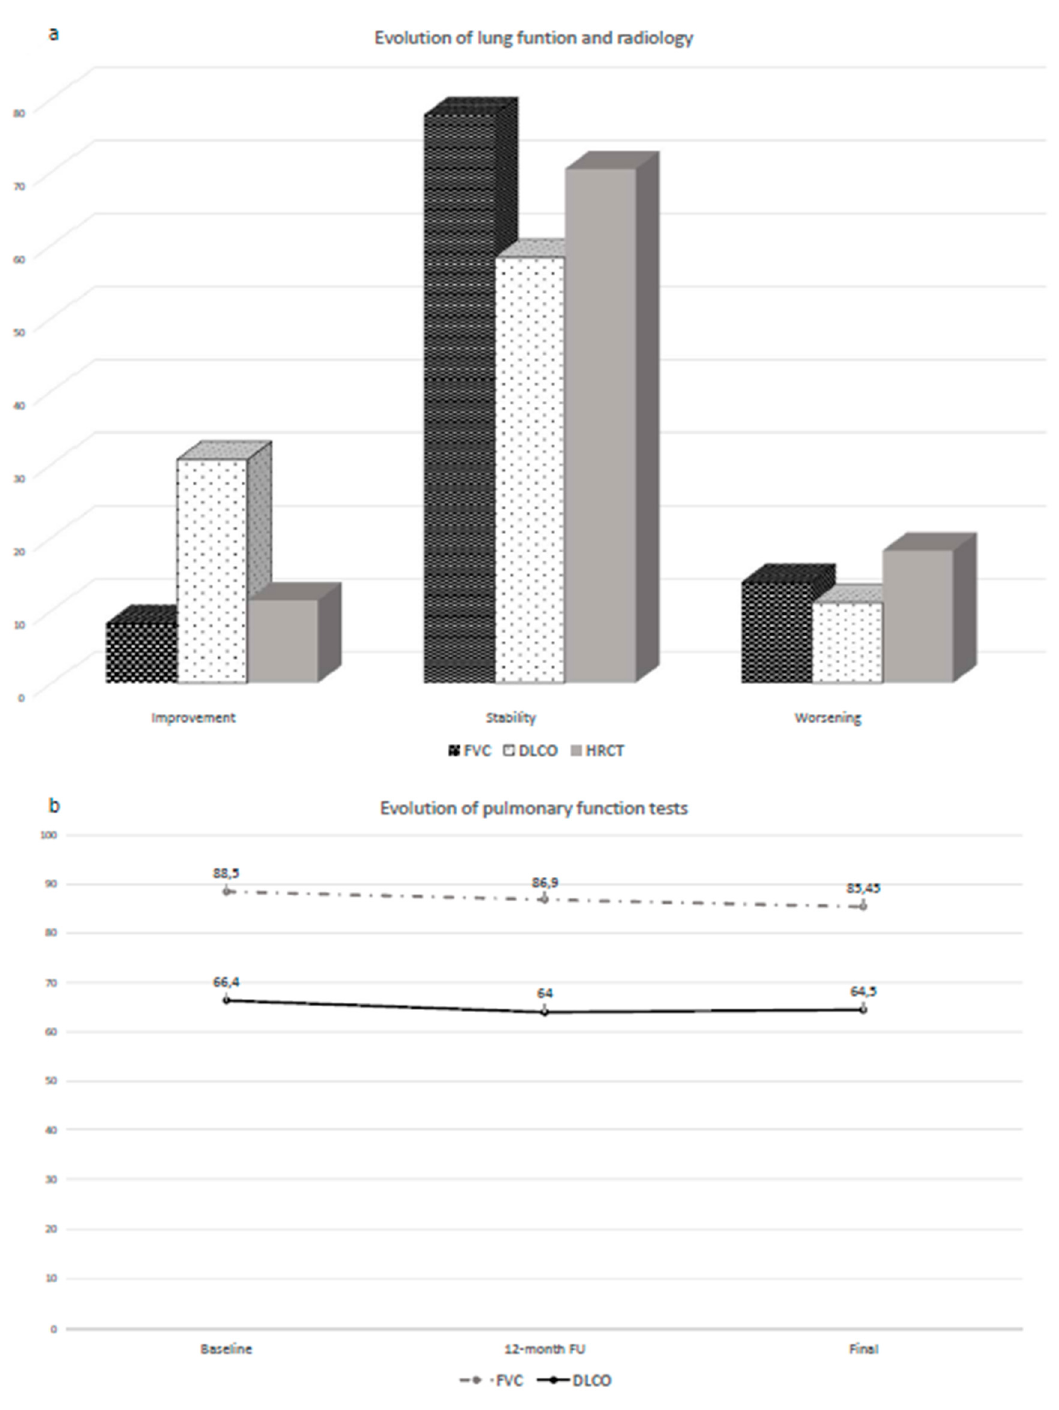
Figure 1. Evolution of lung function and radiology during follow-up. ( a ) During follow-up, FVC remained stable in 77.8% of patients, improved in 8.3% and worsened in 13.9%. During follow-up, DLCO remained stable in 58.3% of patients, worsened in 11.1%, and improved in 30.5%. HRCT was stable in 70.4% of cases, worsened in 18.2%, and improved in 11.4%. ( b ) Evolution of lung function. The median of FVC was 88.5%, 86.9% and 85.45% at baseline, after one year and at the end of follow-up, respectively. The median of DLCO was 66.4%, 64% and 64.5% at baseline, after one year and at the end of follow-up, respectively. FVC: forced vital capacity; DLCO: diffusing capacity of the lung for carbon monoxide; HRCT: high resolution computed tomography.